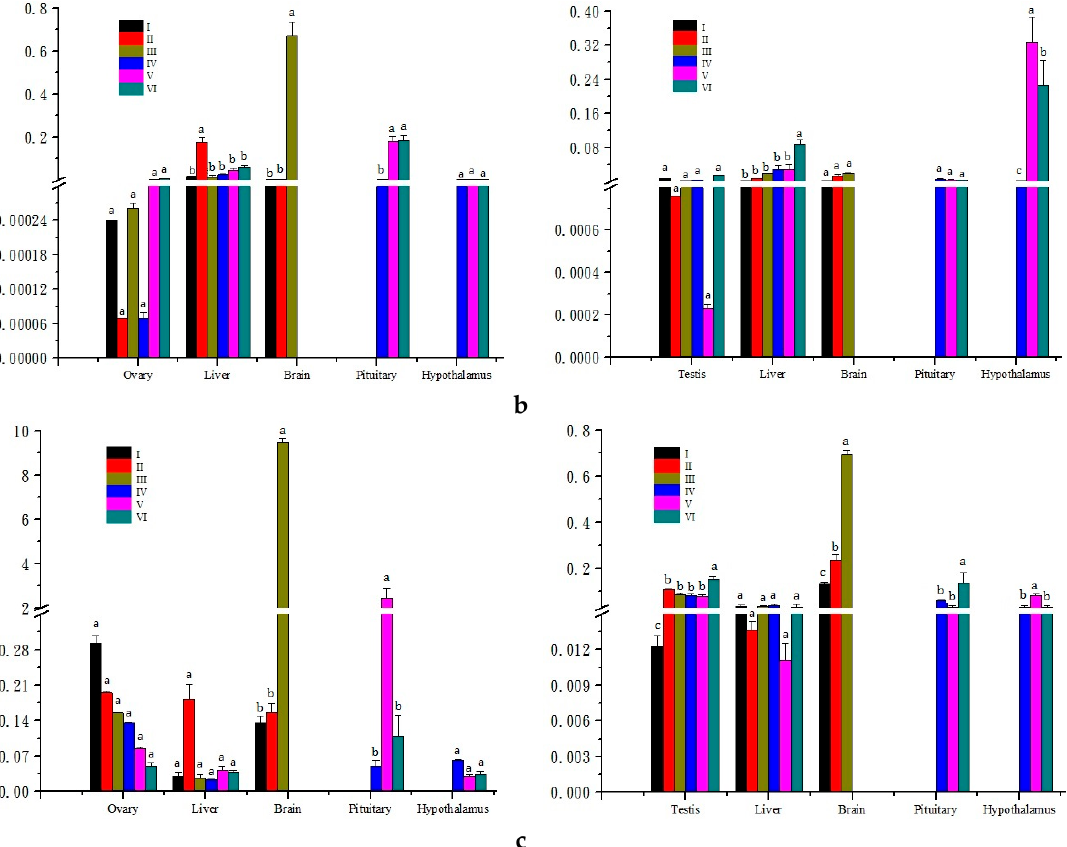
Figure 4. The expression levels of M. amblycephala leptin ( a ); leptinR ( b ); and leprotl1 ( c ) in different tissues during the developmental periods of ovary ( left ) and testis ( right ). The β -actin was used as an internal control to calibrate the cDNA template for all the samples. Vertical bars represent the mean ± SE, and bars with different letters mean significantly different ( p < 0.05).